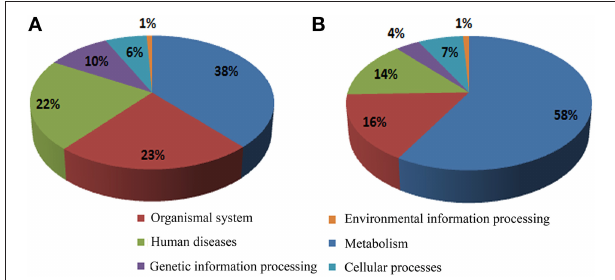
FIGURE 3 | Assignment of cold stress responsive genes to the KEGG Pathway Database. (A,B) Classification of up- and down-regulated genes,